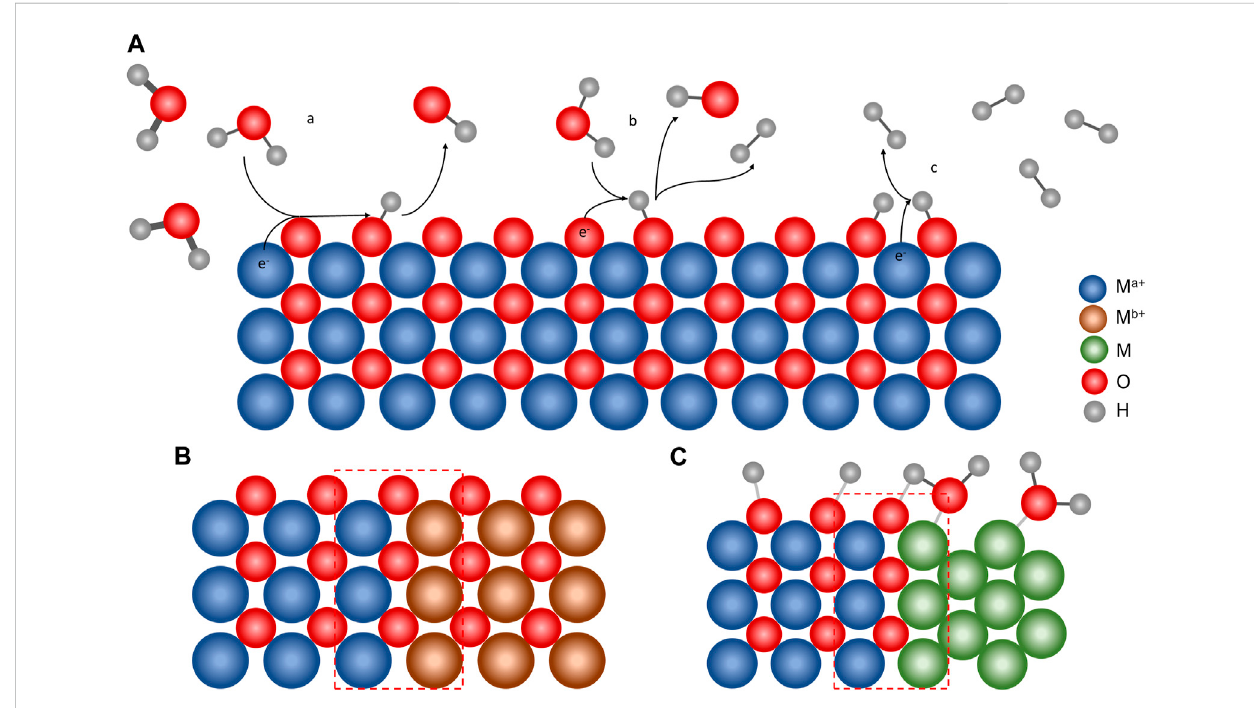
FIGURE 1 (A) Mechanism of the HER on a metal oxide surface, with (a) Volmer, (b) Heyrovsky, and (c) Tafel steps. Material strategies to increase the HER performancebyheterostructuredMMOs: (B) metaloxide/metaloxideand (C) metal/metaloxideinterfaces.Theheterojunctionshowninreddashedlines plays an important role in enhancing the HER activity of the heterostructured